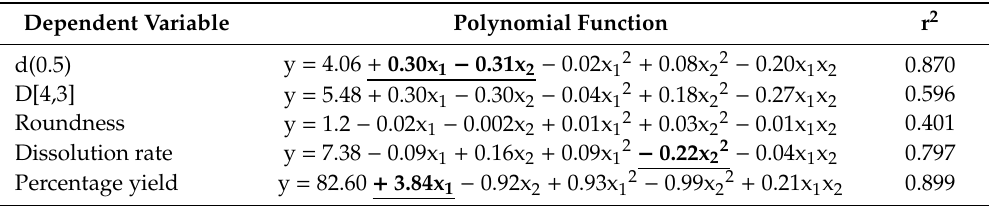
Table 4. Statistical analysis results of the factorial design. (x 1 : Post-mixing time; x 2 : Temperature di ff erence).